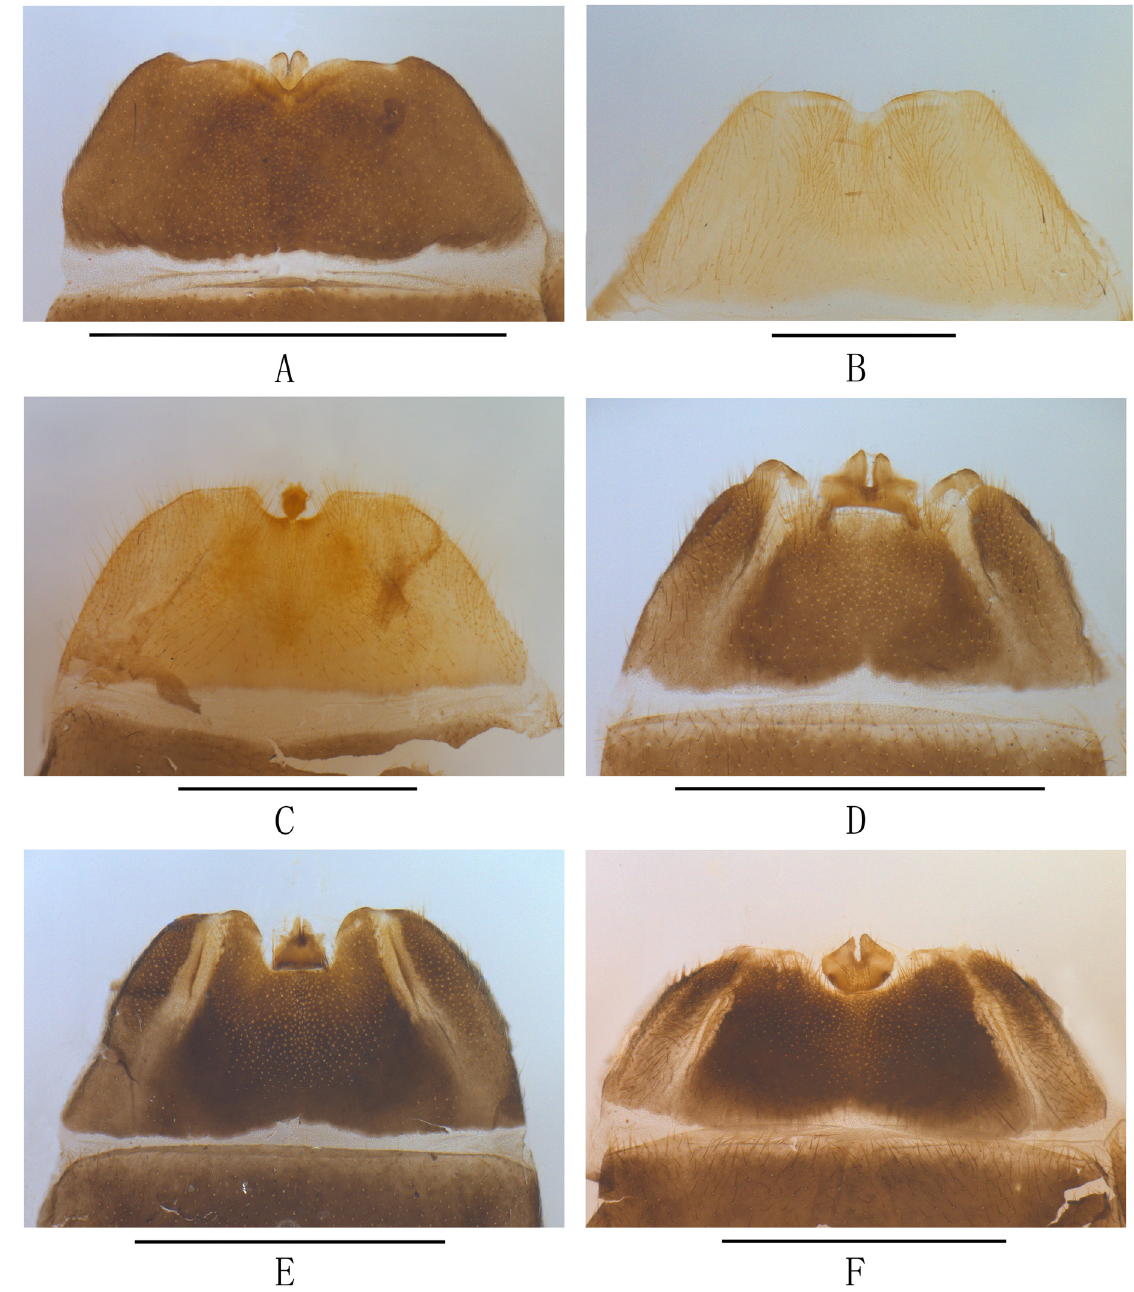
Fig. 7. Abdominal sternite VIII of female, ventral view. A . Stenothemus minutissimus (Pic, 1933) comb. nov. (IZAS, Sichuan). B . S . tryznai Švihla, 2004 (IZAS, Sichuan). C . S . singularicollis (Pic, 1933) comb. nov. (MHBU, Shaanxi). D . S. gracilis Y. Yang & X. Yang sp. nov., paratype (IZAS IOZ(E) 225787). E . S. flavicollis Y. Yang & S. Ge sp. nov., paratype (MHBU HBU(E) 410039). F . S. laticornis Y. Yang & H. Liu sp. nov., paratype (MHBU HBU(E) 410047). Scale bars = 1.0